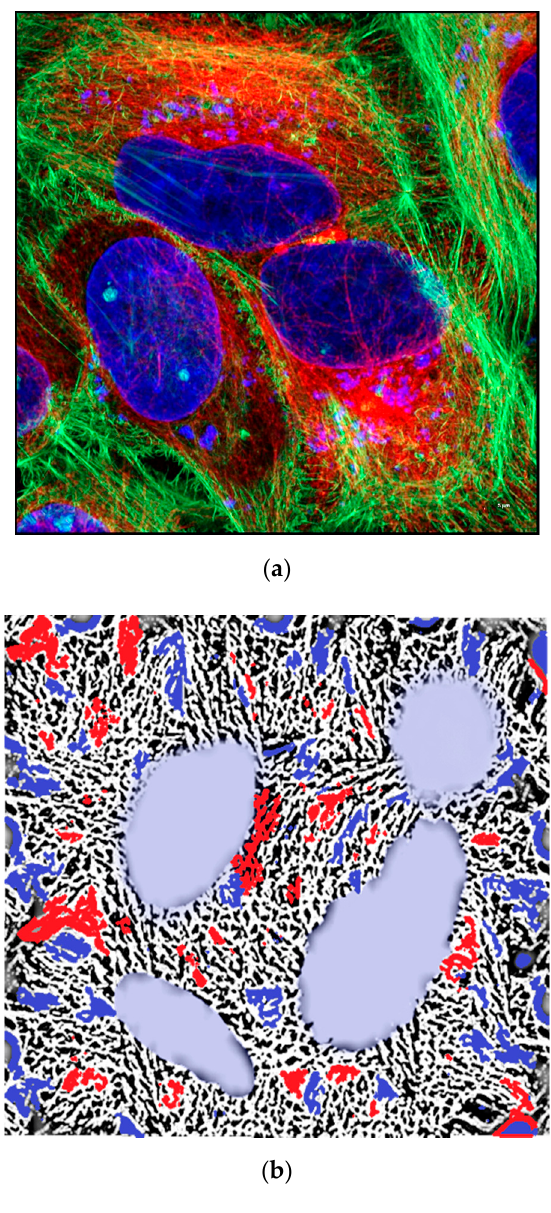
Figure 2. ( a ) Immunofluorescent image of HeLa cells showing actin (green) tubulin (red tubulin antibody labelled with Cy3 secondary) and nucleus (blue). PFA fixed HeLa cells were stained for actin (Phalloidin 488) and alpha tubulin (Alexa 647) and image was taken using airy scan mode in Zeiss 800 confocal microscope using 63× objective. Scale bar = 5 µm. ( b ) Graphical representation of the cytoskeletal components of a cell like actin, tubulin, and intermediate filaments.